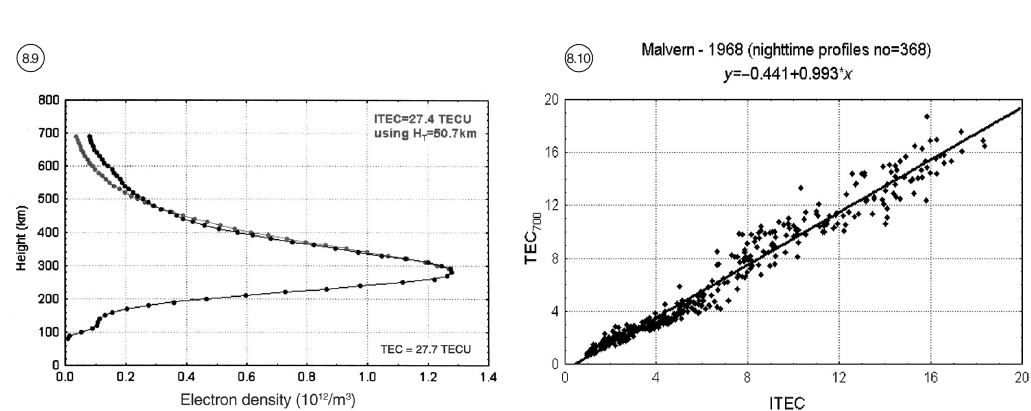
Fig. 8.9. Comparison of the Malvern radar profile (dark line) taken on 18 February 1970 at 14:57 UT, with the profile (grey line) extrapolated according to the Reinisch and Huang (2001) method. Fig. 8.10. Comparison between the ITEC and TEC 700 parameters calculated using the electron density profiles measured by the Malvern radar during nighttime in 1968.